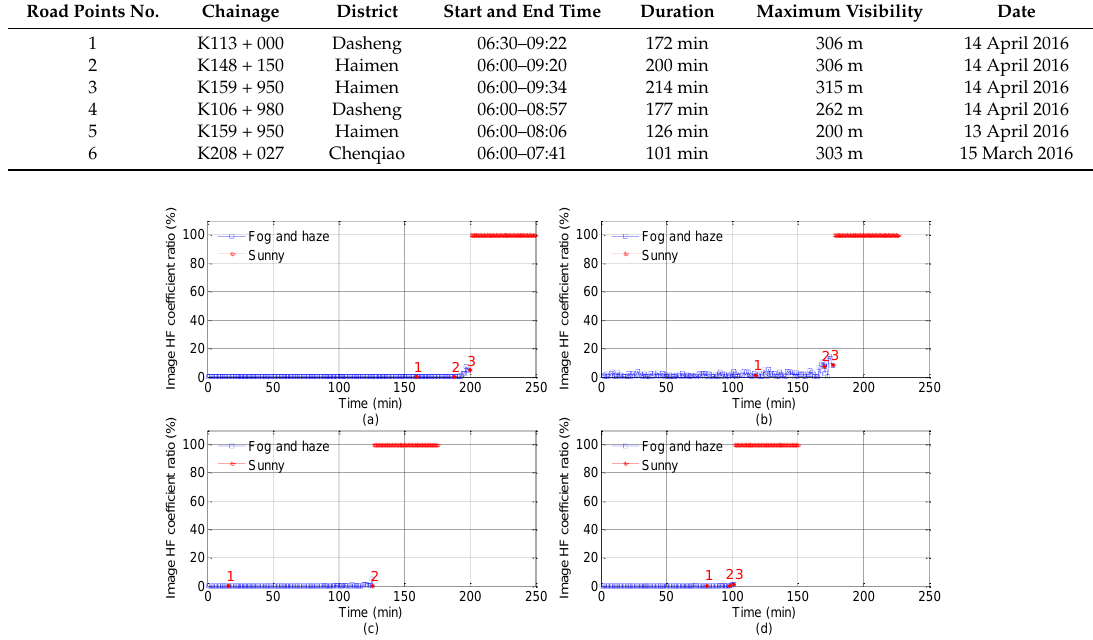
Figure 4. High frequency coefficient ratios (( F r ( n − 1, n − 1) = F l ( n − 1, n − 1) /F h ( n − 1, n − 1). The red numbers 1, 2 and 3 indicate 100 m, 200 m and 300 m, respectively. The upper limit visibility in road points 5 is 200 m, and so there is no red number 3 in ( c ). The ratio values shown in ( a – d ) are corresponding to the Points 2, 4, 5 and 6, respectively.).